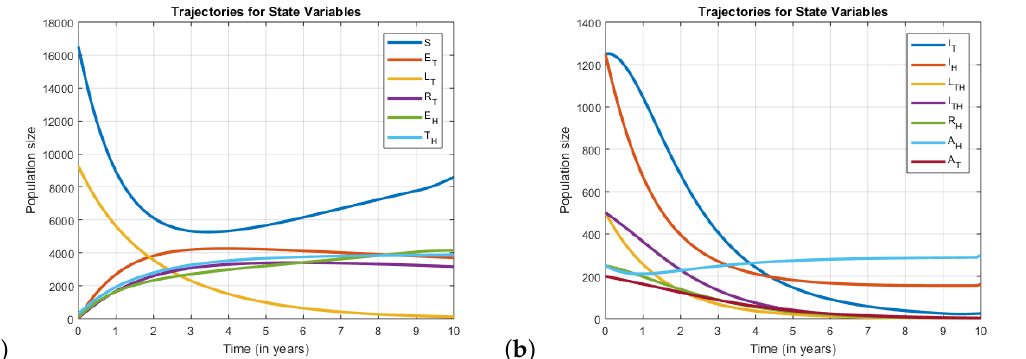
Figure 5. Graphs for the trajectories of the sub-populations when controls are applied. All the parameter values are as described in the caption of Figure